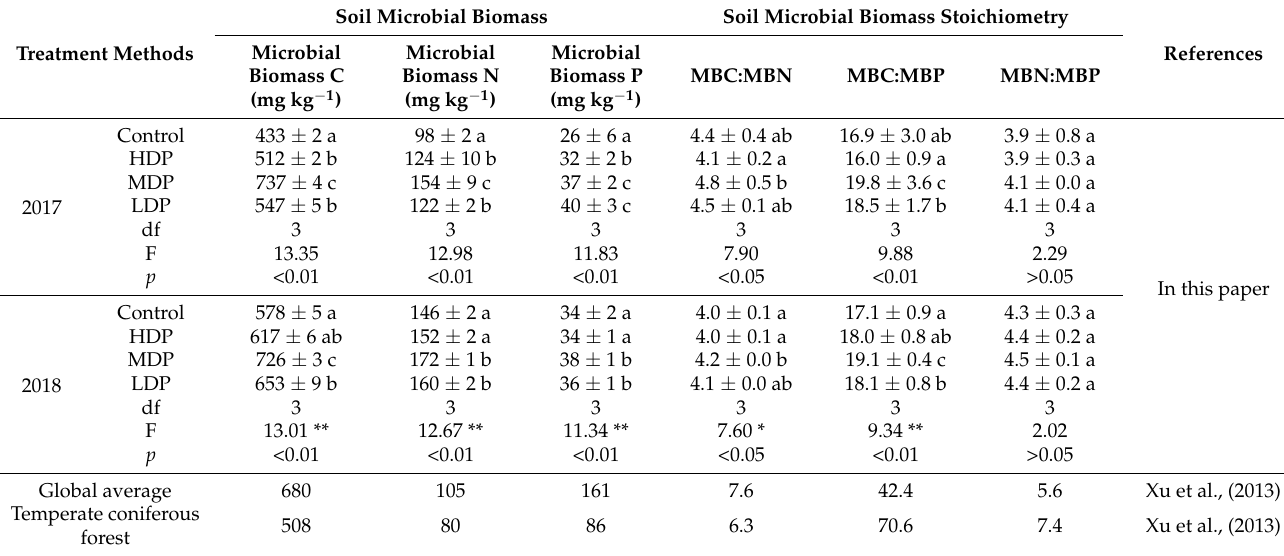
Table 3. Comparison of soil microbial biomass and its stoichiometric ratios within 10 cm soil layers in various scale. Soil Microbial Biomass Treatment Methods